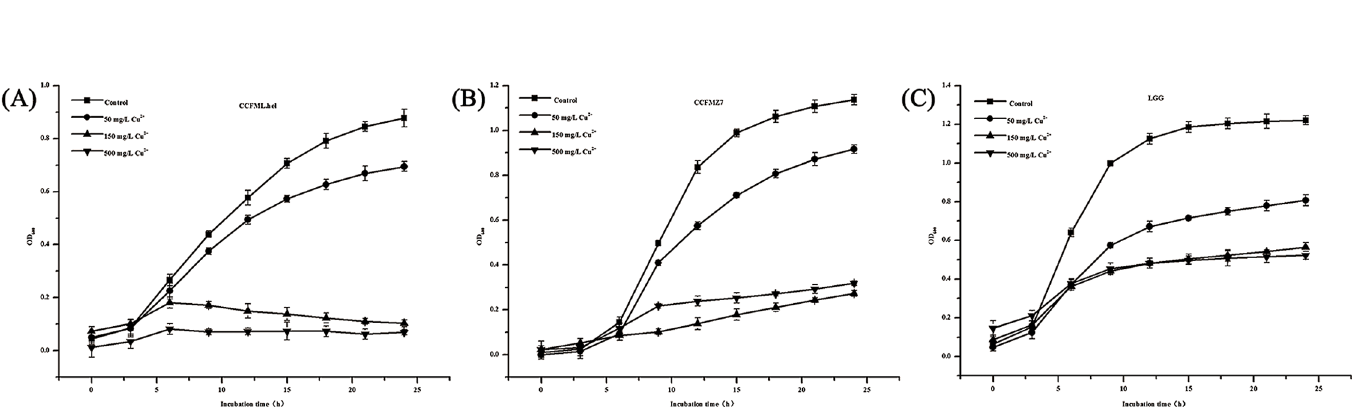
Fig 4. The third kind of growth of strains in different copper ion MRS broths. The subgraphs (A) to (C) show the tolerance ability of CCFML.hel, CCFMZ7 and LGG, respectively.